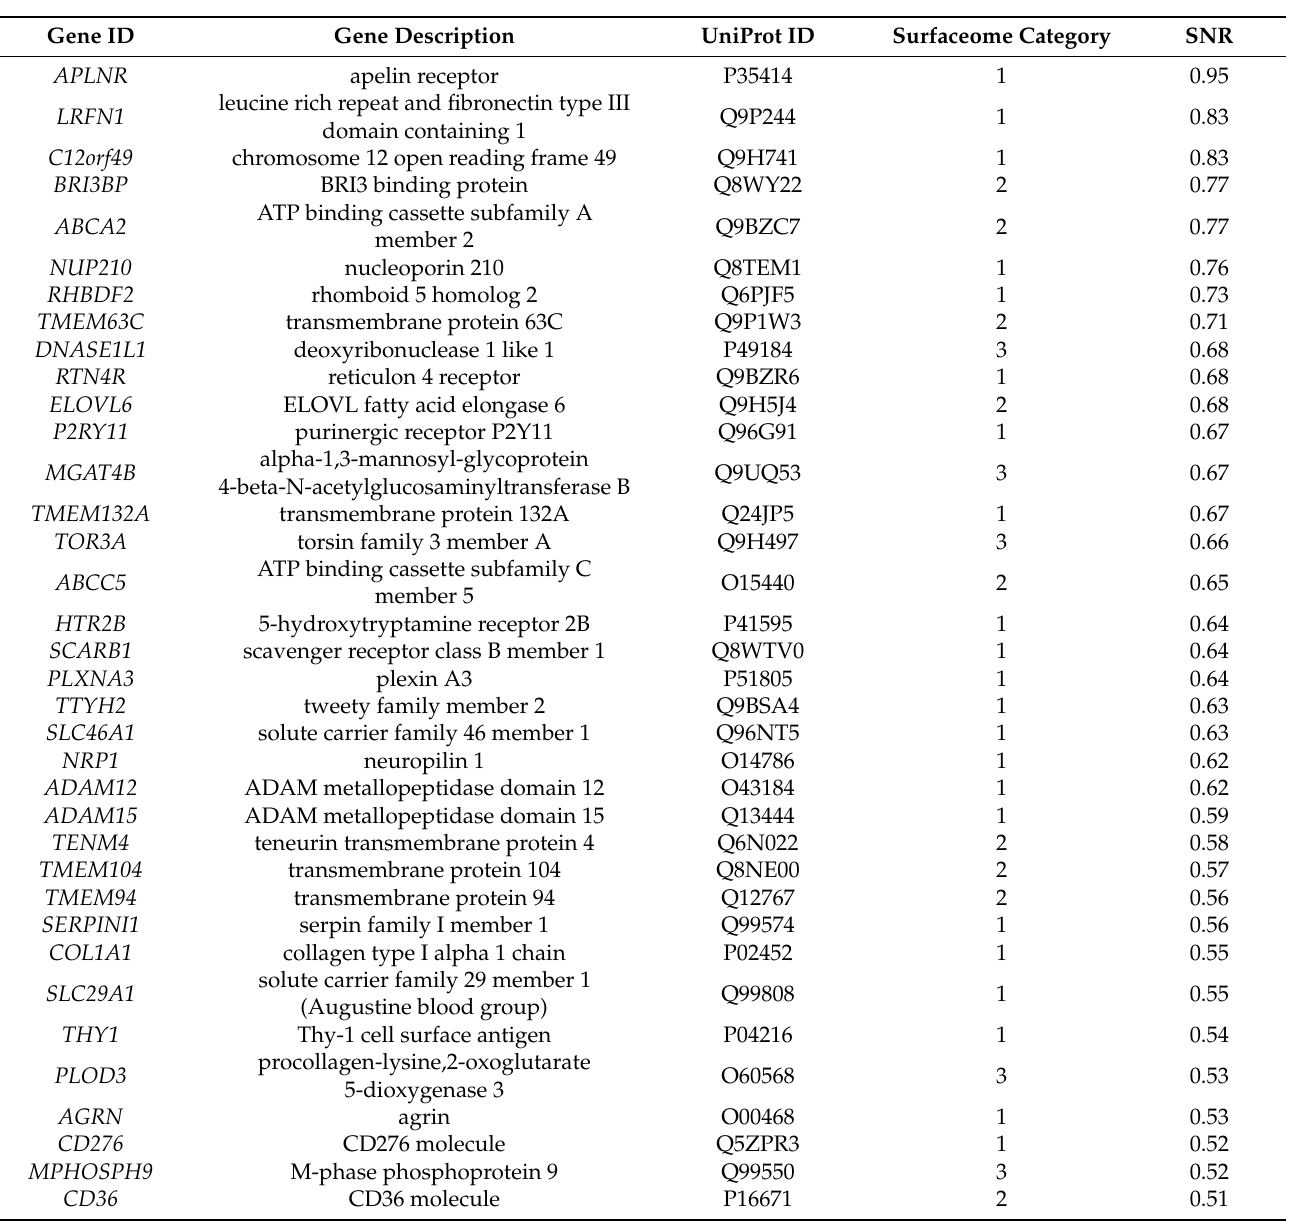
Table 1. List of the most highly upregulated (metastasis vs. PT) genes coding for surface bound proteins. SNR = signal-to- noise ratio (metastasis vs. PT); permutation p value for all genes = 0.002; Surfaceome CSPA (Cell Surface Protein Atlas) category: 1 = high confidence, 2 = putative, 3 =